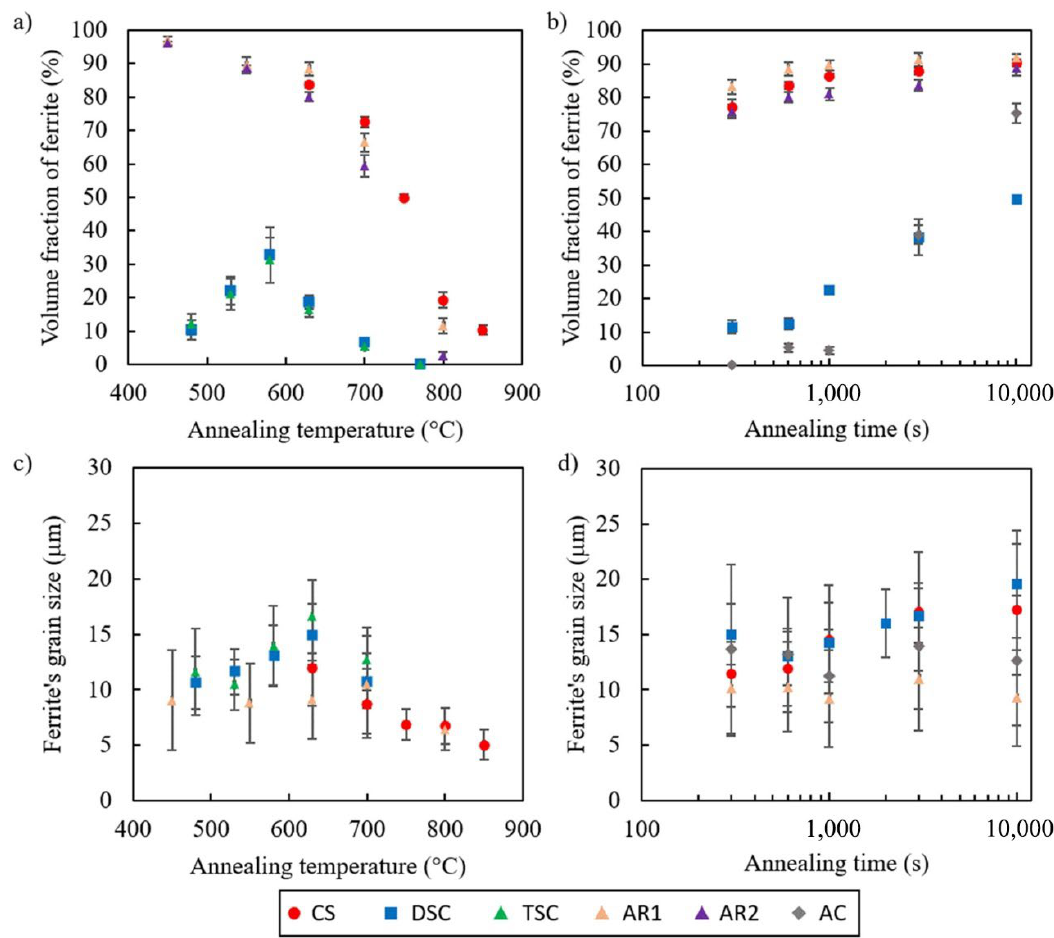
Figure 6. ( a , b ) Volume fraction and ( c , d ) grain size of ferrite with respect to annealing conditions (legend applies to all graphs).